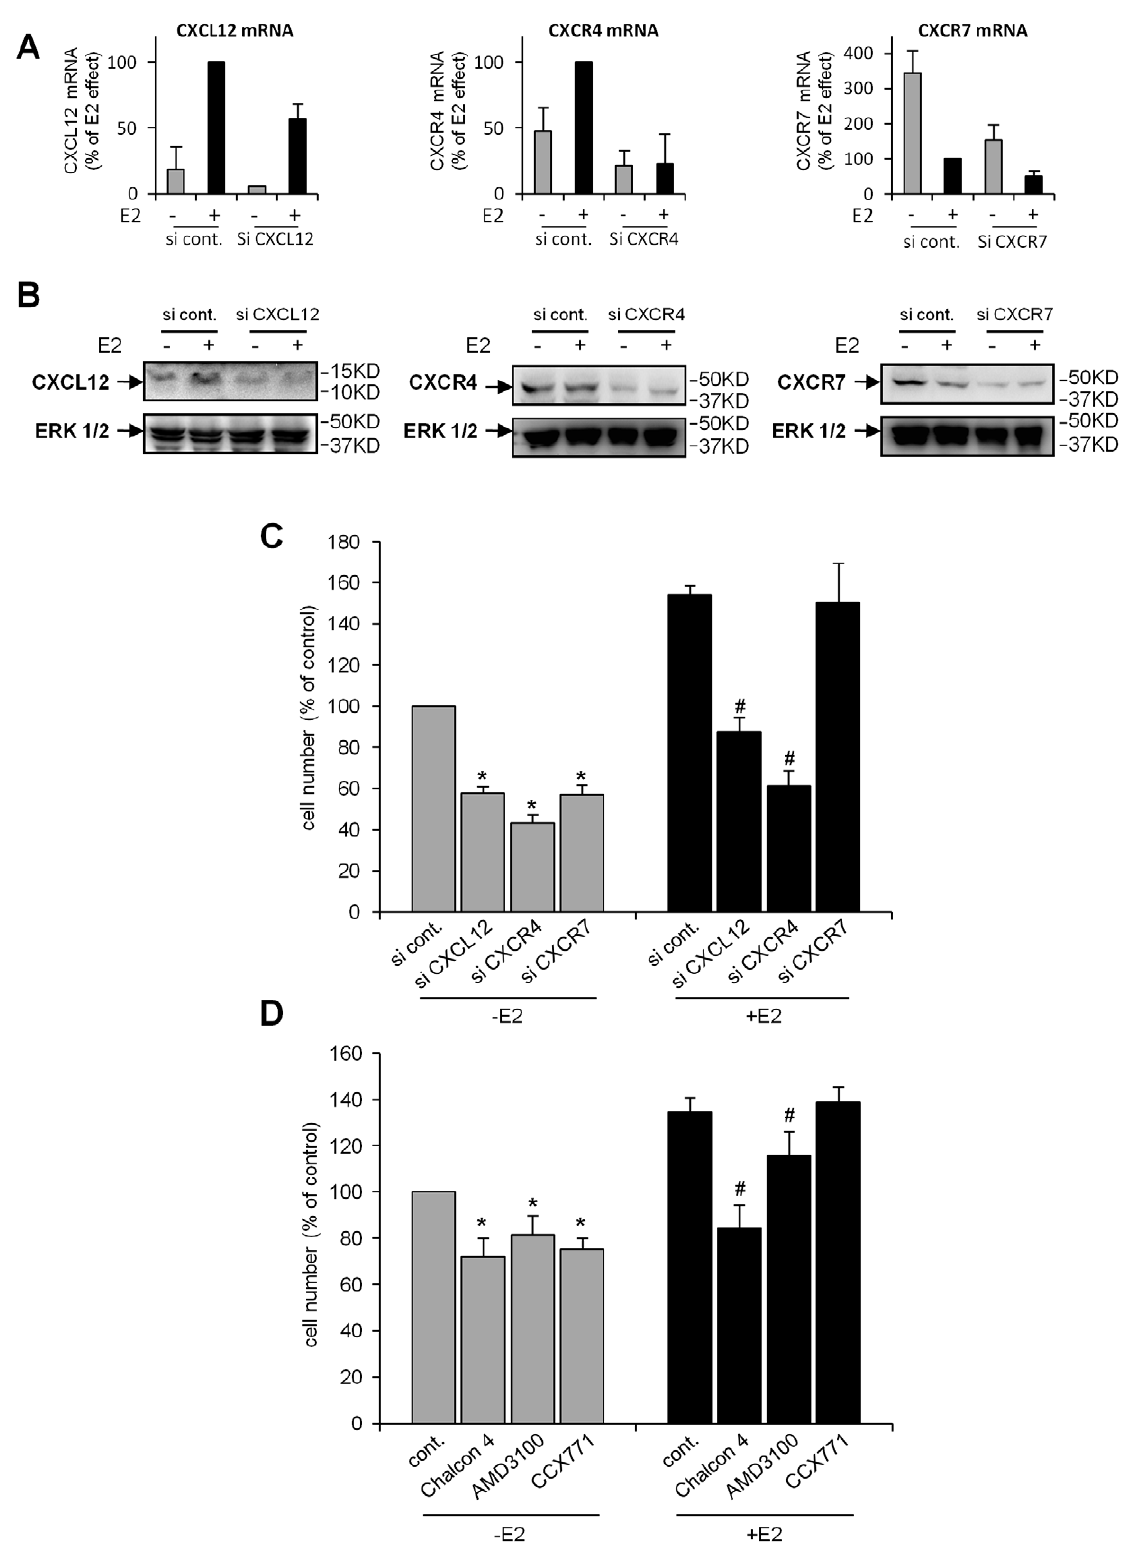
Figure 5. Involvement of CXCL12, CXCR4 and CXCR7 in the E2-dependent and -independent growth of MCF-7 cells. siRNA directed against CXCL12, CXCR4 or CXCR7 was transfected into MCF-7 cells treated with EtOH ( 2 ) or 10 2 8 M E2 ( + ). (A) After 48 h, the levels of the CXCL12, CXCR4 and CXCR7 transcripts were assessed by quantitative PCR and normalized against GAPDH mRNA. The results were compared with those obtained from MCF-7 cells transfected with a nonspecific siRNA control. (B) Total protein was extracted from MCF-7 cells, and the levels of CXCL12, CXCR4 and CXCR7 were analyzed by Western blotting. (C) To determine the growth rate of the MCF-7 cells, the siRNA-transfected cells were treated